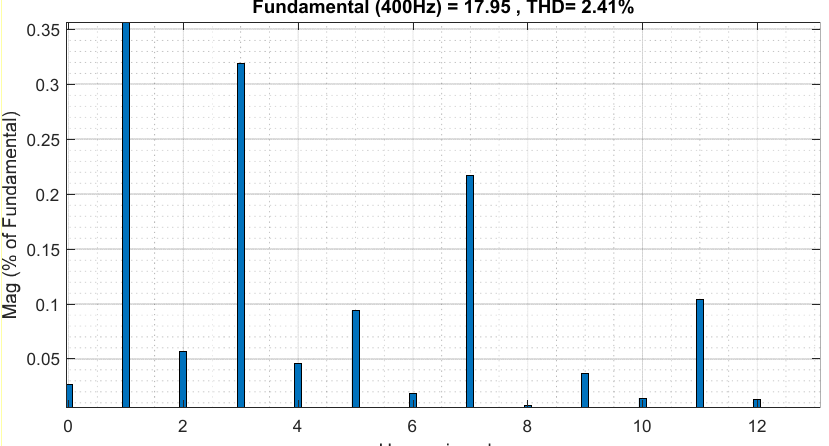
Figure 16. FFT analysis of output current.